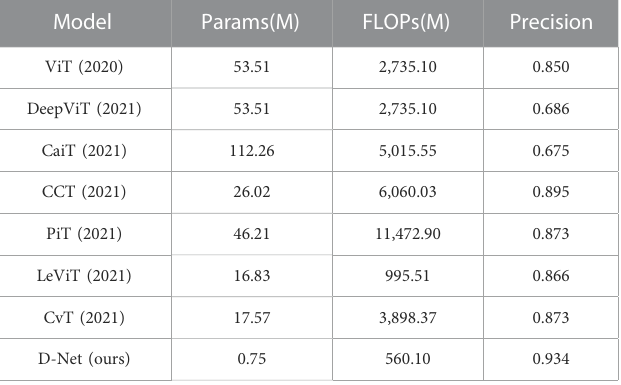
TABLE 4 D-Net and Transformer algorithm model data comparison. While ViT, DeepViT, CaiT, and PiT are more cutting-edge approaches with superior experimental performance, CCT, LeViT, and CvT are lighter ways.